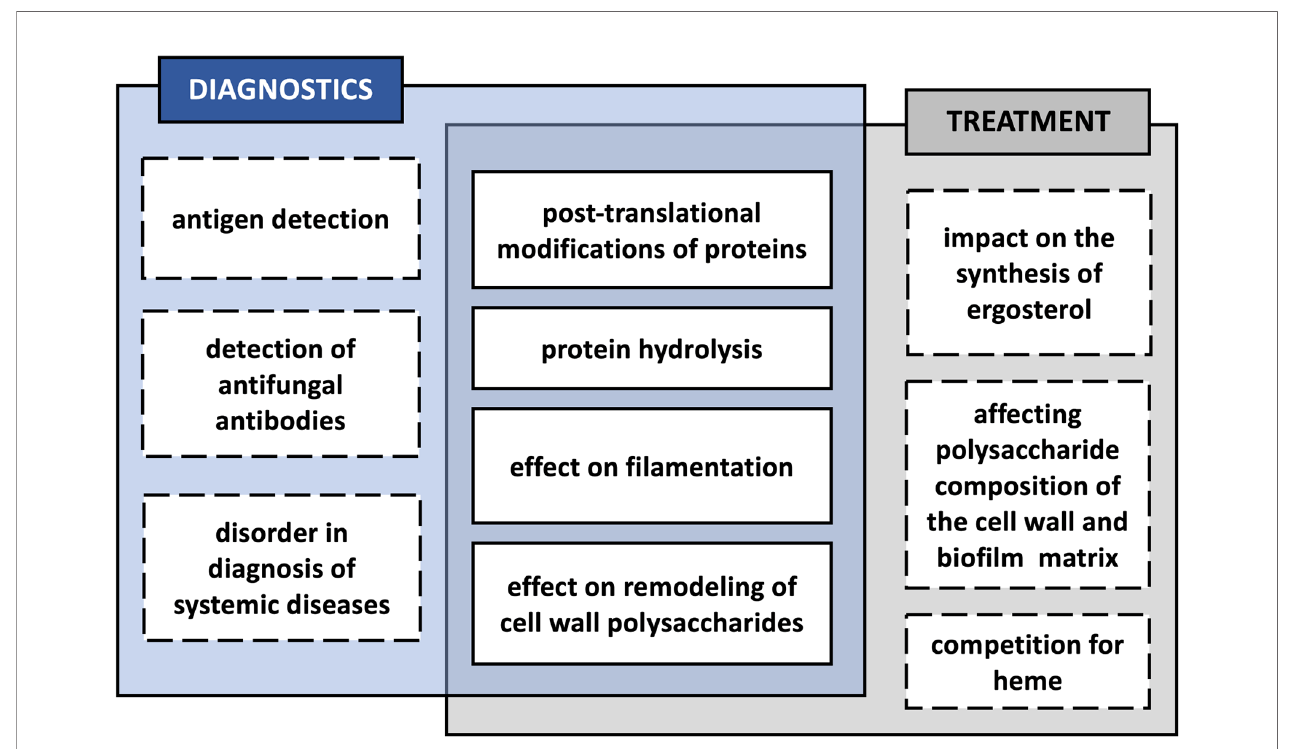
FIGURE 3 | Potential effects of the interaction of Candida albicans with bacteria in a bio fi lm, in fl uencing the diagnosis and treatment of mixed